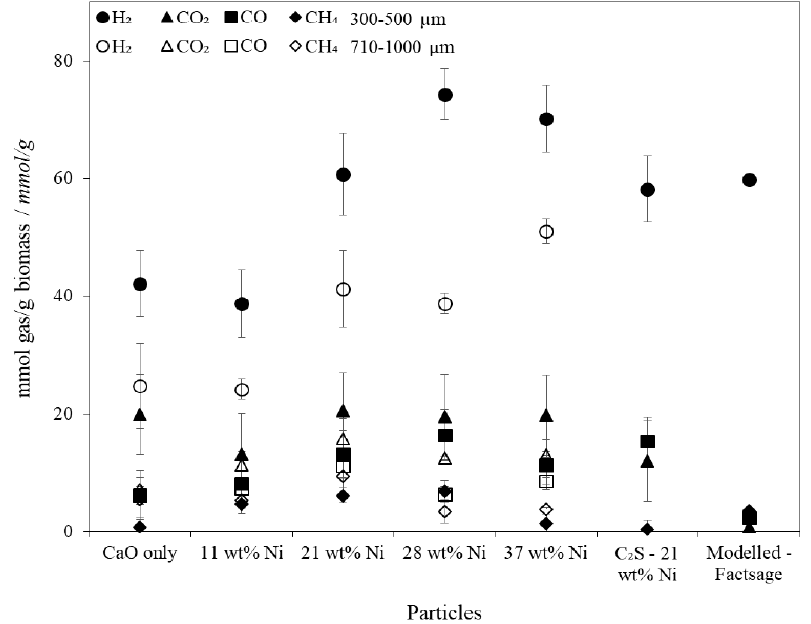
Figure 7. Millimoles of each product gas per gram of biomass from whole reaction period during biomass Sorption Enhanced Steam Reforming (SESR) in a fluidised bed reactor with varying compositions of combined particles.